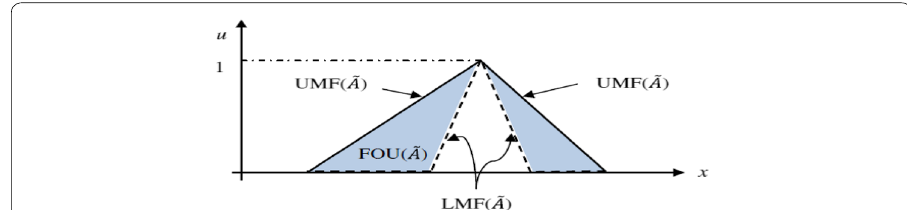
Fig. 15 FOU, UMF and LMF for an IT2 FS